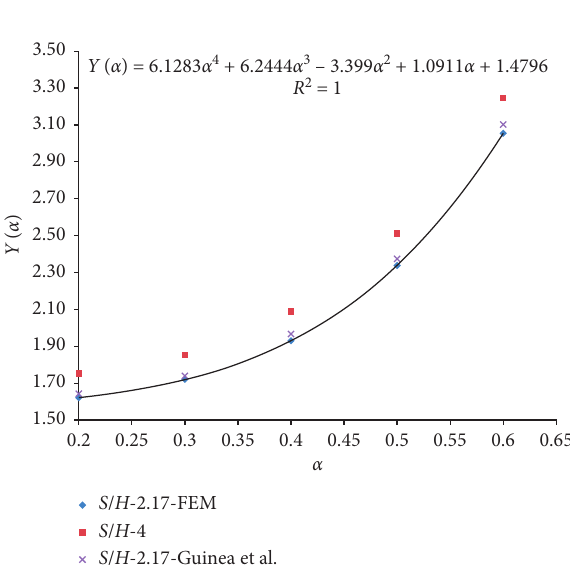
Figure 3: V ( α ) versus relative crack length α (square red points indicate values obtained from formulas of Tada et al. for S / H �